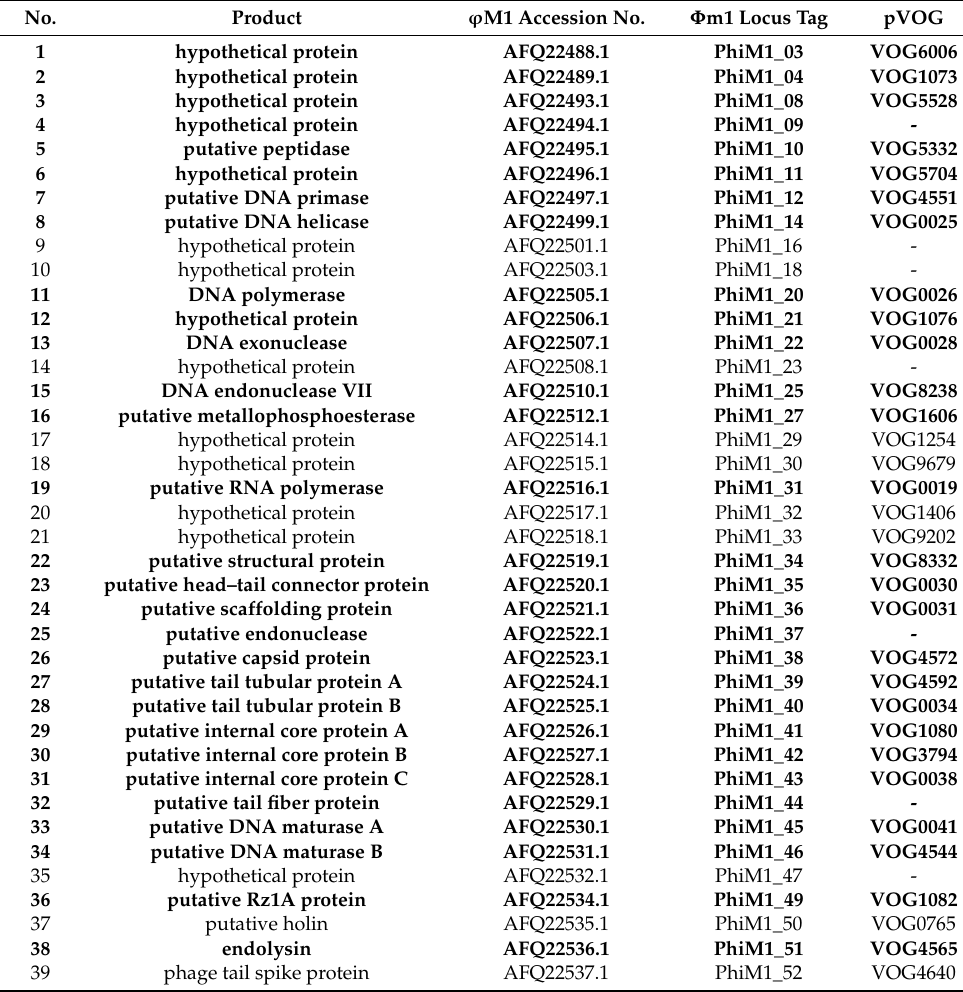
Table 3. Thirty-nine conserved genes among phages ( ϕ M1, Peat1, CB5, PP90) of the proposed genus ‘ Phimunavirus ’, as determined by CoreGenes, and their details with regard to the type phage ϕ M1. Conserved proteins of these phages shared with Klebsiella phage KP34 are highlighted in bold. Additionally, prokaryotic Virus Orthologous Groups (pVOGs) determined from translated ORFs of ϕ M1 of these conserved proteins are